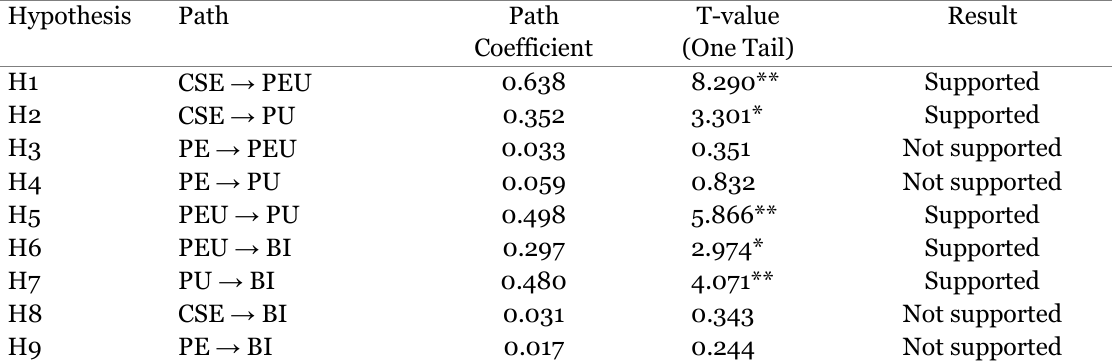
Path Coefficients and Hypotheses Testing (Direct